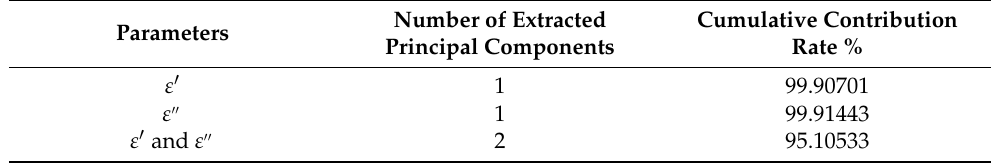
Table 2. Principal Component Analysis Extraction Results.